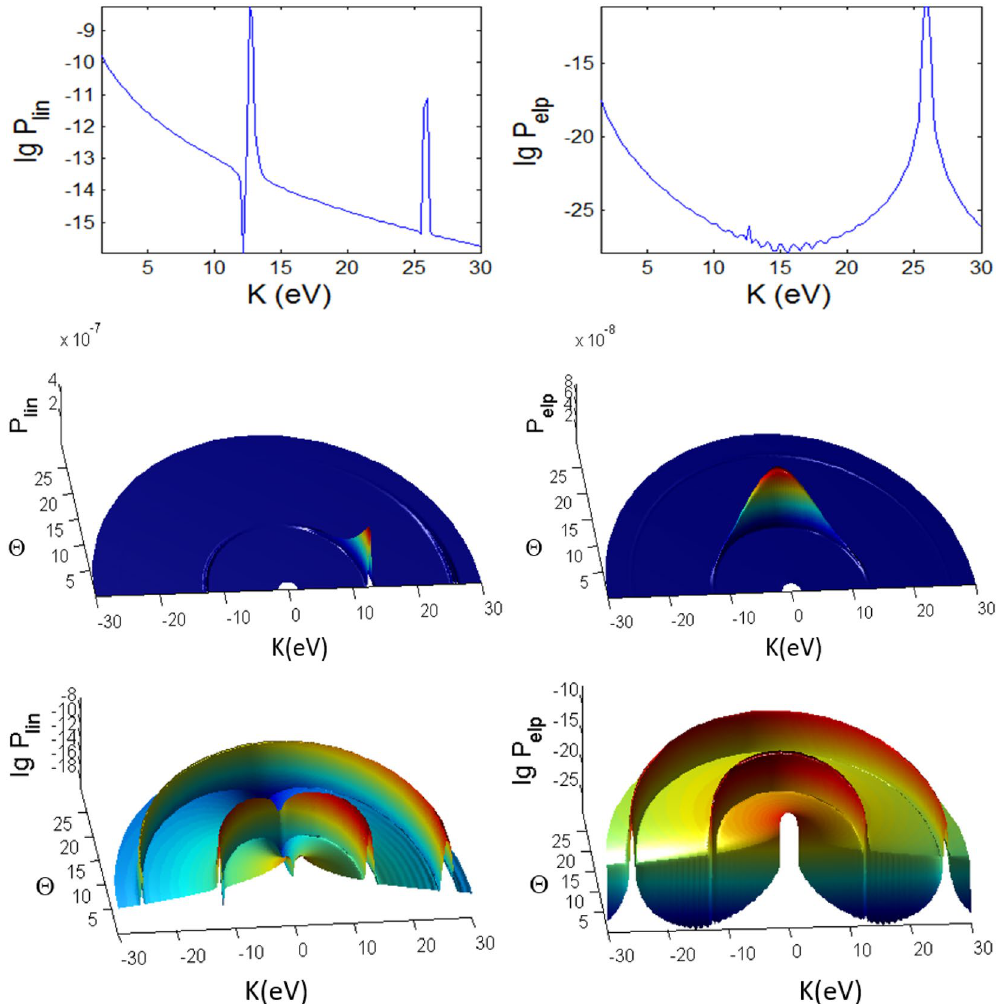
Figure 8. Same as Fig. 6 (photoionization probability for t p = 100 fs , versus Θ at Φ = 0 and K ) but for Case C characterizing the MPI